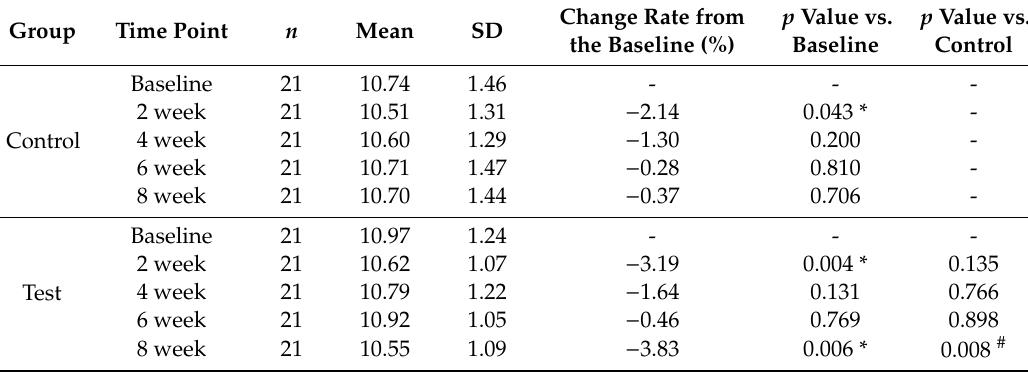
Table 7. Skin redness (a* value) of the control and test groups.